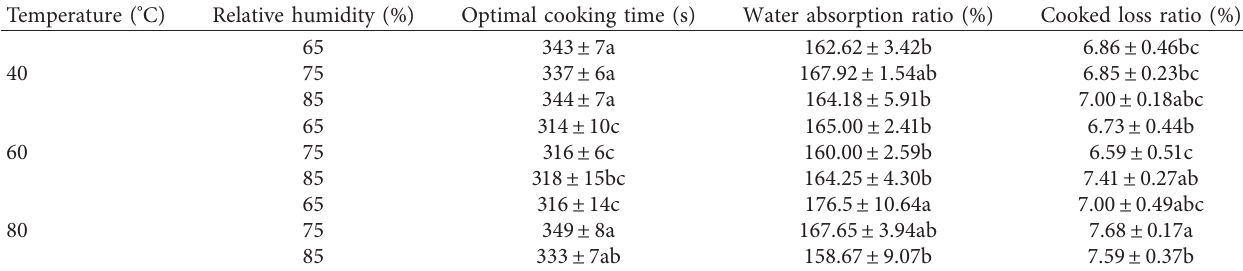
Table 3: Effects of drying temperature and relative humidity on cooking quality characteristics of CDN.